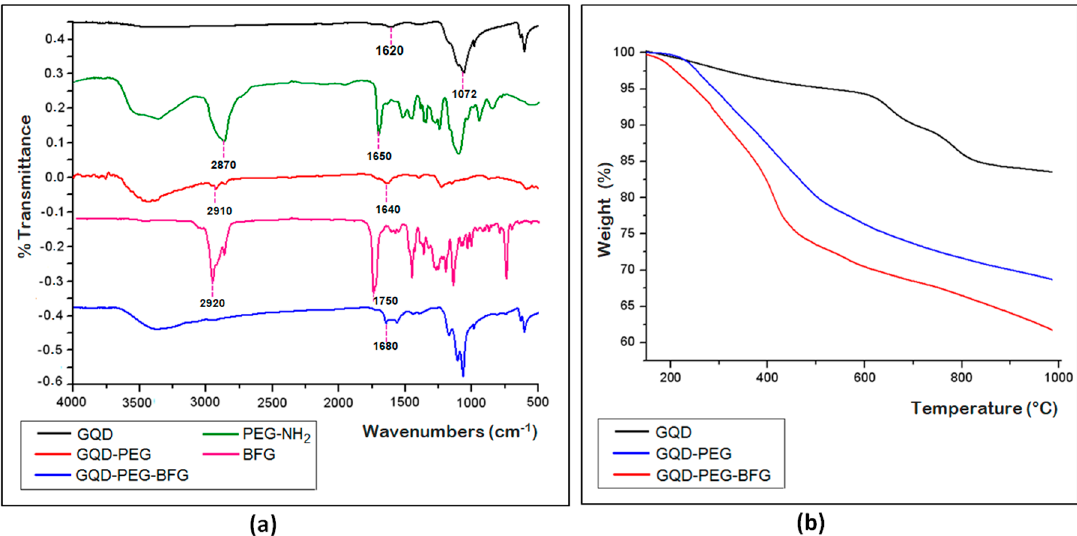
Figure 3. ( a ) FTIR spectra of GQD, GQD-PEG, GQD-PEG-BFG, PEG-NH 2 , and BFG; ( b ) TGA curves for GQD, GQD-PEG, and GQD-PEG-BFG. The experiments were performed under an argon